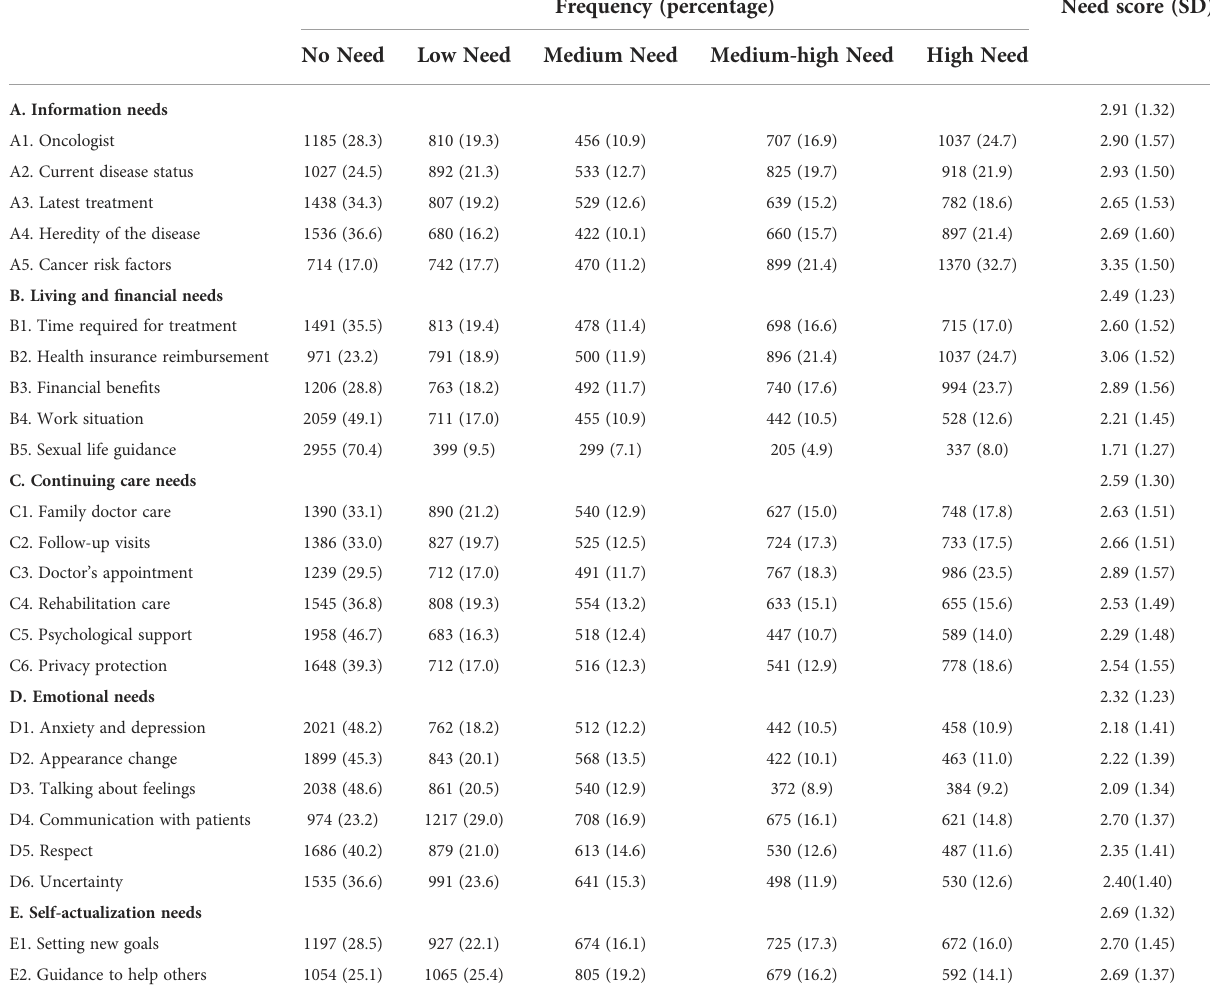
TABLE 2 Results of descriptive statistics on unmet need for supportive care across fi ve